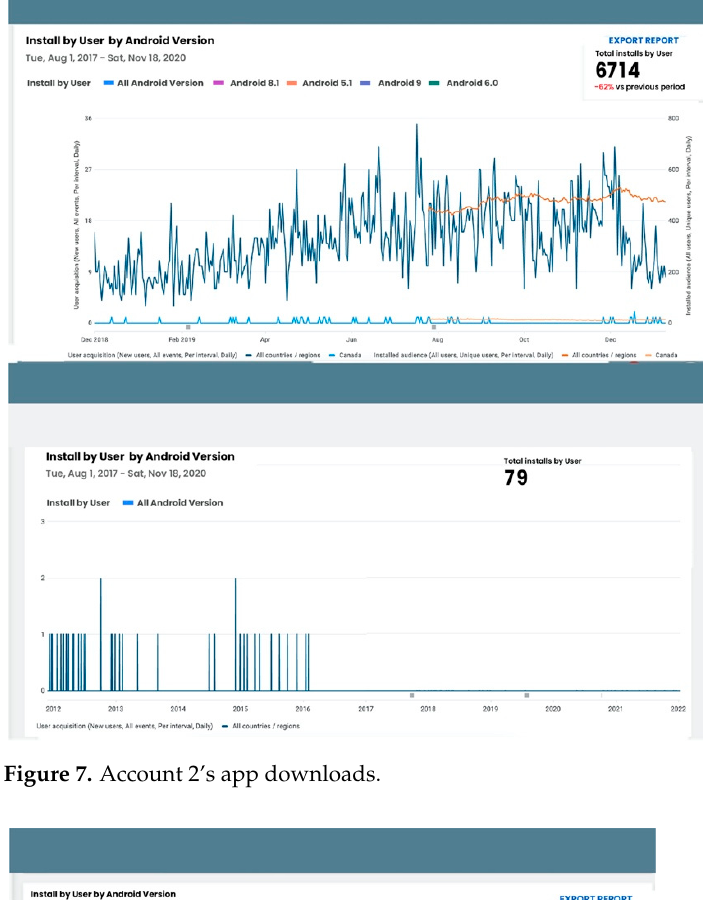
Figure 6. App downloads from account 1.